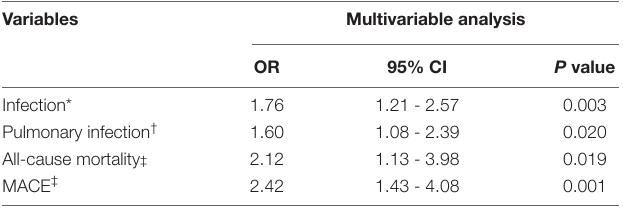
TABLE 2 | Multivariable analysis of proton pump inhibitor for in-hospital adverse events. Variables